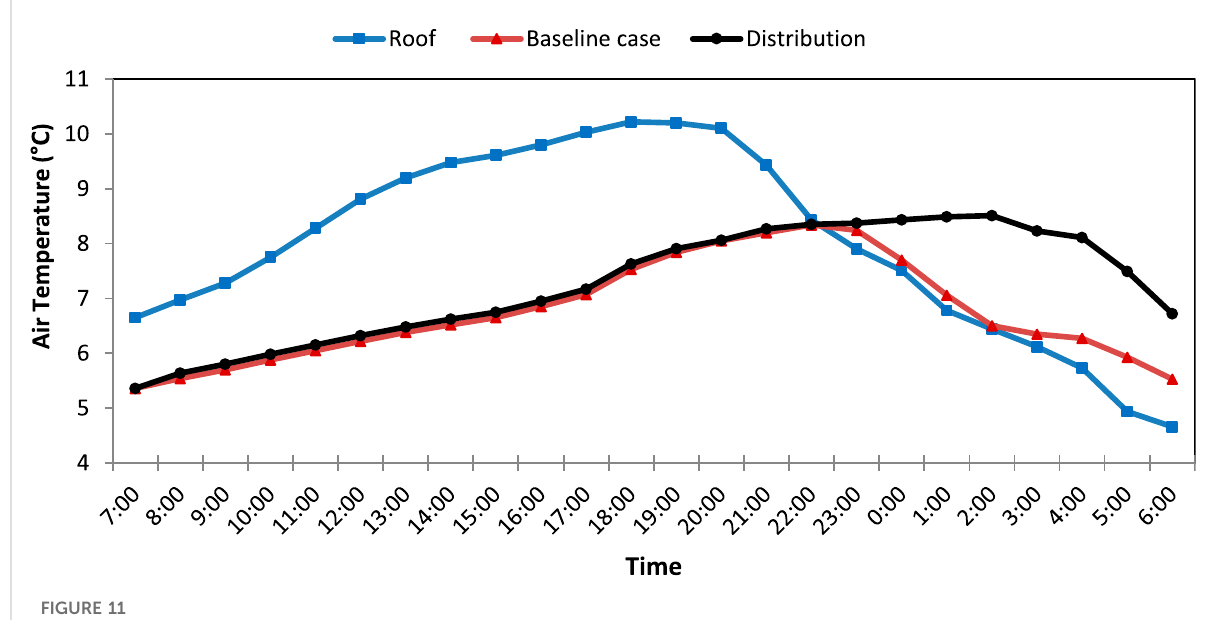
FIGURE 11 Comparison of temperature variation between recycled glass distribution and baseline case for roof and room 1 in